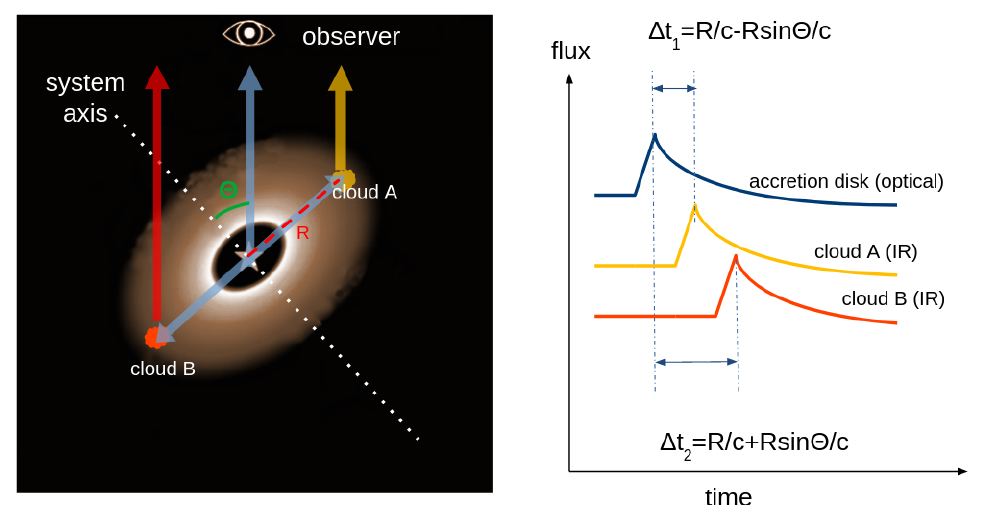
Figure 12. Illustration of the basic concepts of AGN dust reverberation mapping. Assuming two identical dusty clouds (the red and yellow clouds in the figure) at the same distance, R , to the central engine (the blue star), their IR variability signals will be relatively delayed to the optical flare from the accretion disk by ∆ t 1 = ( R / c )( 1 − sin θ ) (yellow lines) and ∆ t 2 = ( R / c )( 1 + sin θ ) (red lines), where c is the speed of light and θ is the viewing angle of the observer relative to the system axis. In a more realistic case, the IR reverberation signals seen in one band come from a composite of clouds at some ranges of distance and scale height with some possible radiation transfer